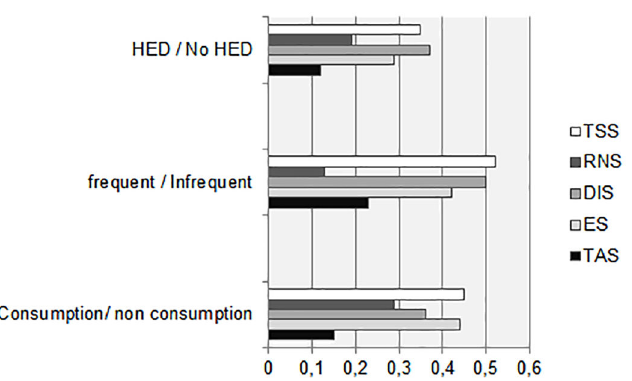
Figure 1. Effect sizes of the difference in sensation seeking, according to the pattern of alcohol consumption. Note. HED = Heavy episodic drinking; RNS = Risk and novelty seeking; DIS = Disinhibition; ES = Experience seeking; TAS = Thrill and adventure